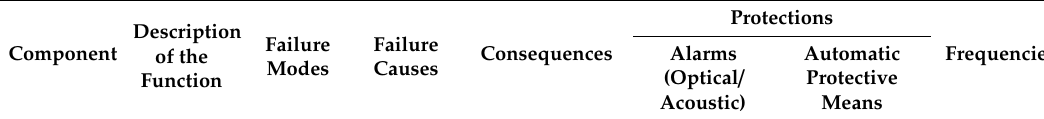
Table 1. Classic FMEA